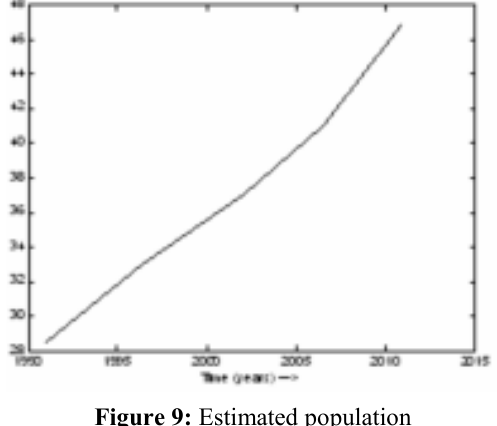
Figure 9: Estimated population